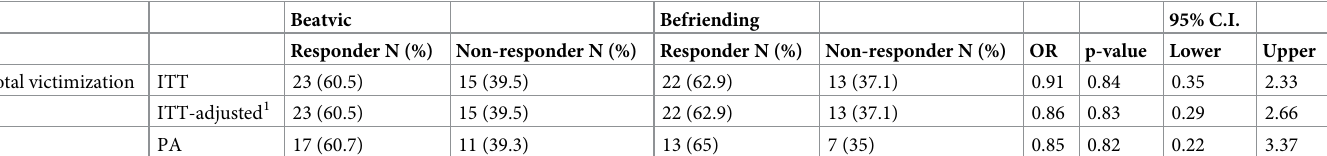
Table 2. Observed percentage of participants with treatment response at 6 month follow-up and results of the logistic regression analyses for primary outcome treatment response for total victimization. Beatvic Befriending 95% C.I.